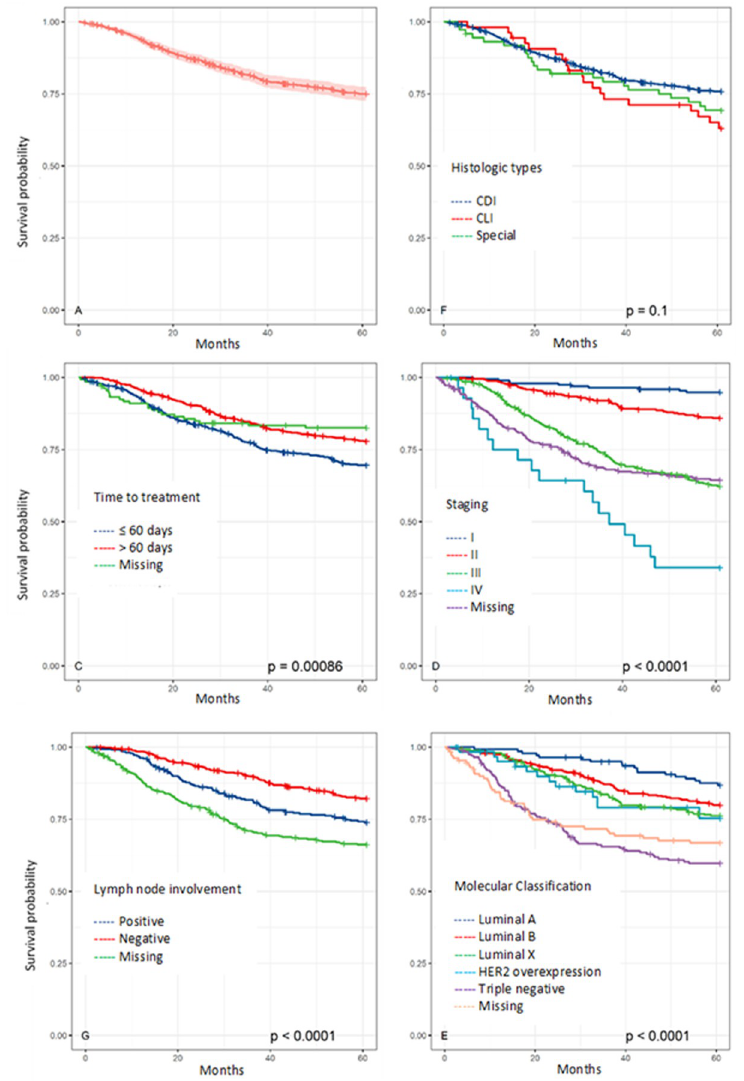
Fig 2. Cancer-specific survival and mean cancer-specific survival of breast cancer patients by histology type, time to treatment, staging, lymph node involvement, and molecular classification.